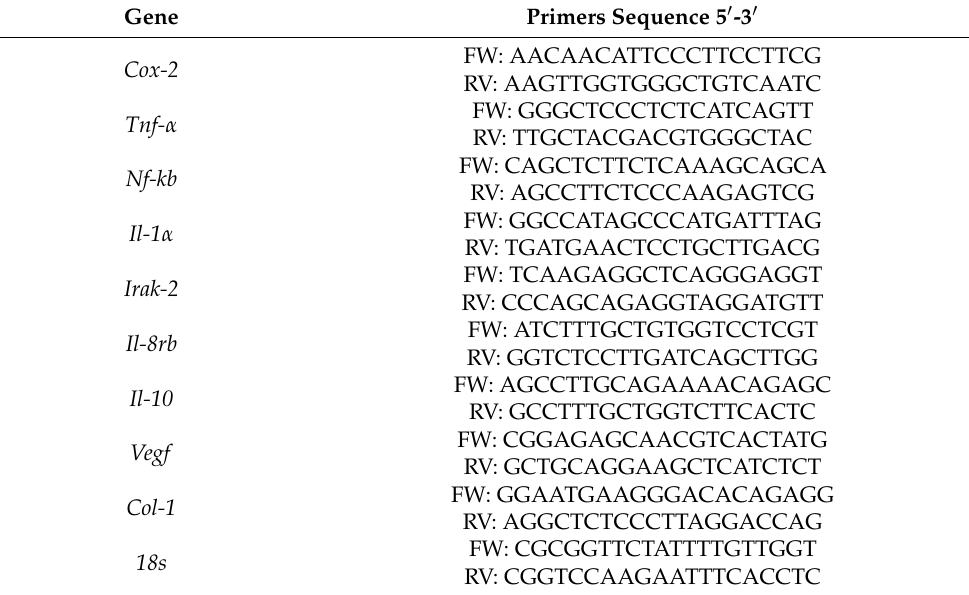
Table 4. Sequence of primers used in